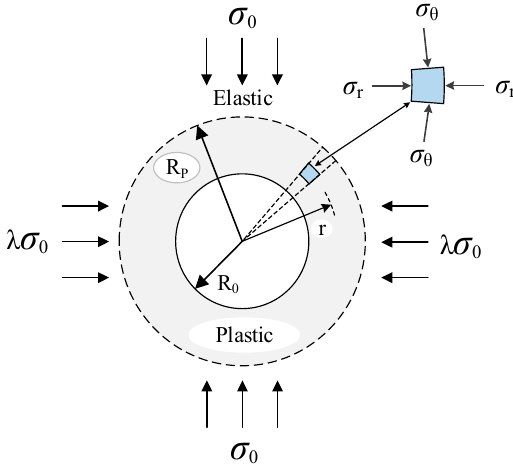
Figure 1. Circular tunnel in an elastic–plastic material subjected to inhomogeneous stress.